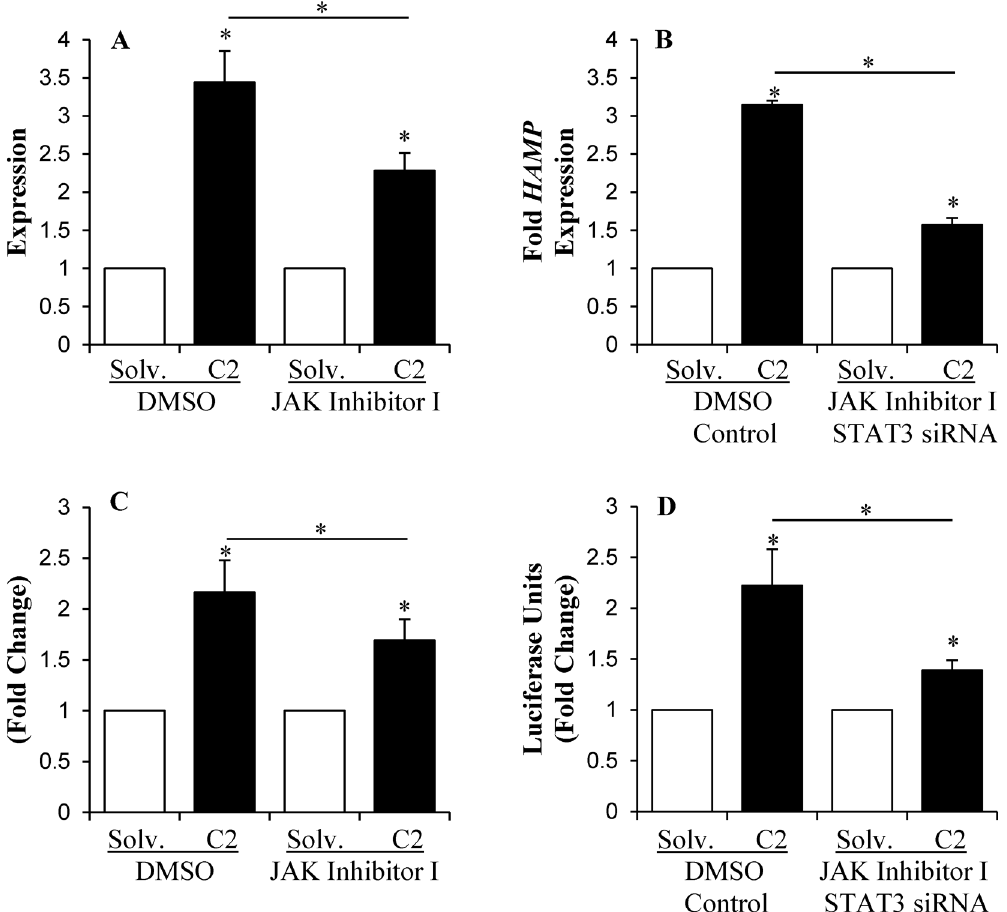
Fig 5. Activation of STAT3 signaling was required for the induction of HAMP transcription by ceramide (A) HAMP mRNA expression in HepG2 cells, treated with solvent (solv.) or C2 ceramide for 8 hours in the presence of either 5 μ M JAK inhibitor I or DMSO (control), was determined by Taqman qPCR. HAMP expression in treated cells was calculated as fold change of that in respective control cells treated with solvent. (B) HepG2 cells, pre-transfected with STAT3 or control siRNA, were treated with C2 ceramide or solvent (solv.) in the presence of 5 μ M JAK inhibitor I or DMSO. HAMP mRNA levels, determined by qPCR, were expressed as fold expression of that in respective controls treated with solvent. (C) HepG2 cells, transfected with pGL3-basic vector harboring 0.6 kb HAMP promoter, were treated with C2 ceramide or solvent (solv.) for 8 hours in the presence or absence of 5 μ M JAK inhibitor I. Dual luciferase assays were performed and HAMP promoter activity, calculated as fold change of that in corresponding control cells treated with solvent, was expressed in relative luciferase units. (D) HepG2 cells, pre-transfected with STAT3 or control siRNA, were subsequently transfected with pGL3-basic vector harboring 0.6 kb wild-type HAMP promoter. After treatment with solvent (solv.) and C2 ceramide in the presence of either JAK inhibitor I or DMSO, dual luciferase reporter assays were performed. HAMP promoter activity, expressed as relative luciferase units, was expressed as fold change of that in respective control cells treated with solvent. Asterisks indicate statistical significance (P <